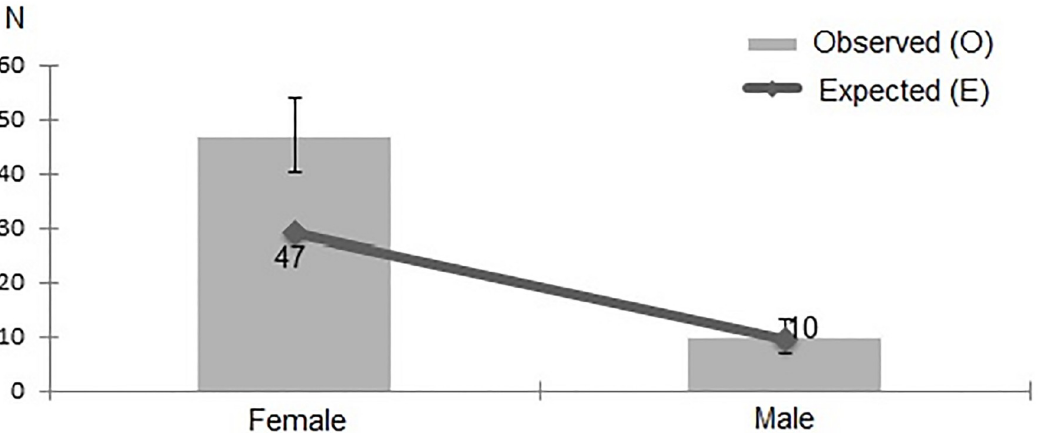
Fig 6. Gender distribution of JHS patients, as diagnosed with Hakim & Grahame criteria.